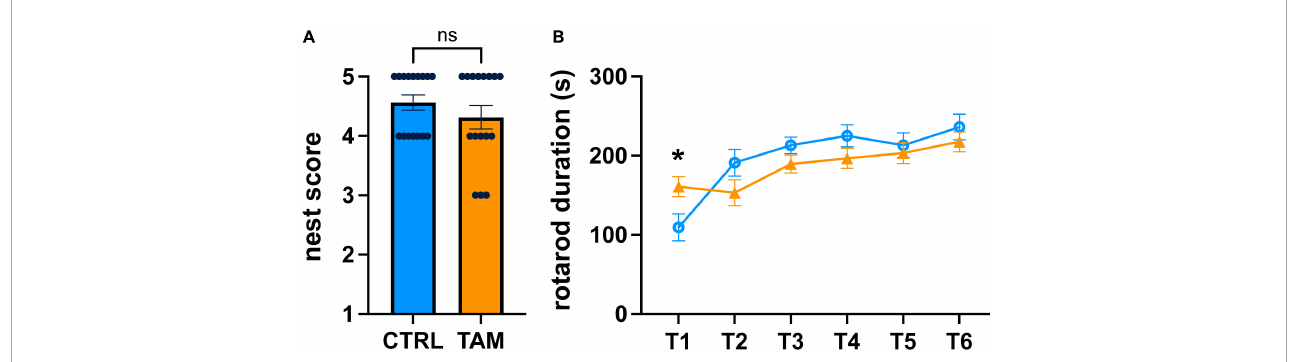
FIGURE3 Tamoxifen effects on general health or motor skill learning and coordination. Blue lines and bars show results from control (CTRL) mice; orange lines and bars show tamoxifen-treated mice (TAM). (A) Scoring of nests built by single-housed mice overnight based on comparison to well-defined figures ranked from 1 (no nesting) to 5 (full nest). (B) Performance on standard motor learning task measured as latency to fall off the accelerating rod from trial 1 (T1) to trial 6 (T6). N = 16 mice per group; mean ± standard error. For a comparison of the initial ability to perform the rotorod task, a t -test was conducted individually for T1 (* p < 0.02).